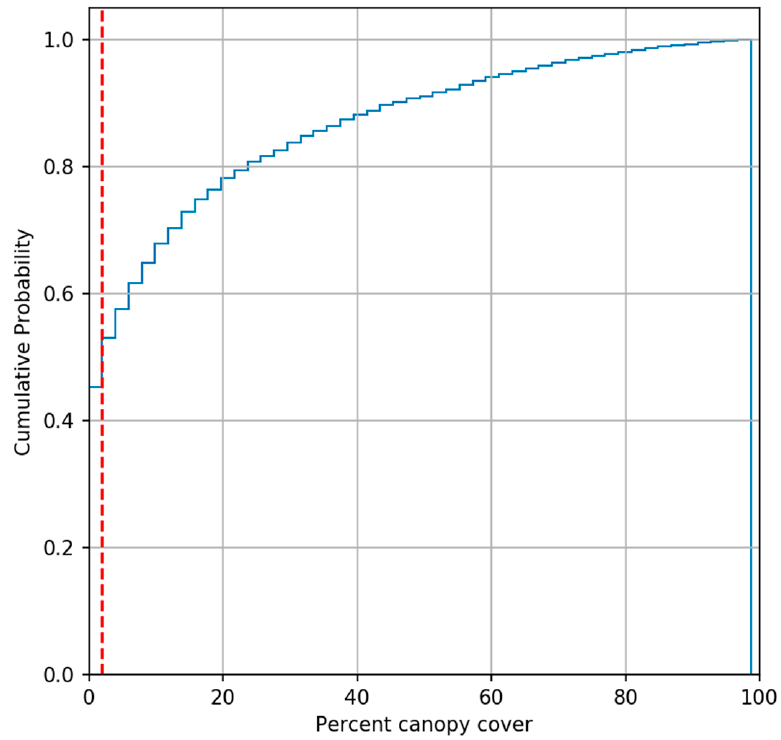
Figure 2. Cumulative probability distribution of cheatgrass canopy cover at field sample locations. The red line illustrates a strong break at 2% canopy cover and is used to define cover classes for this study.